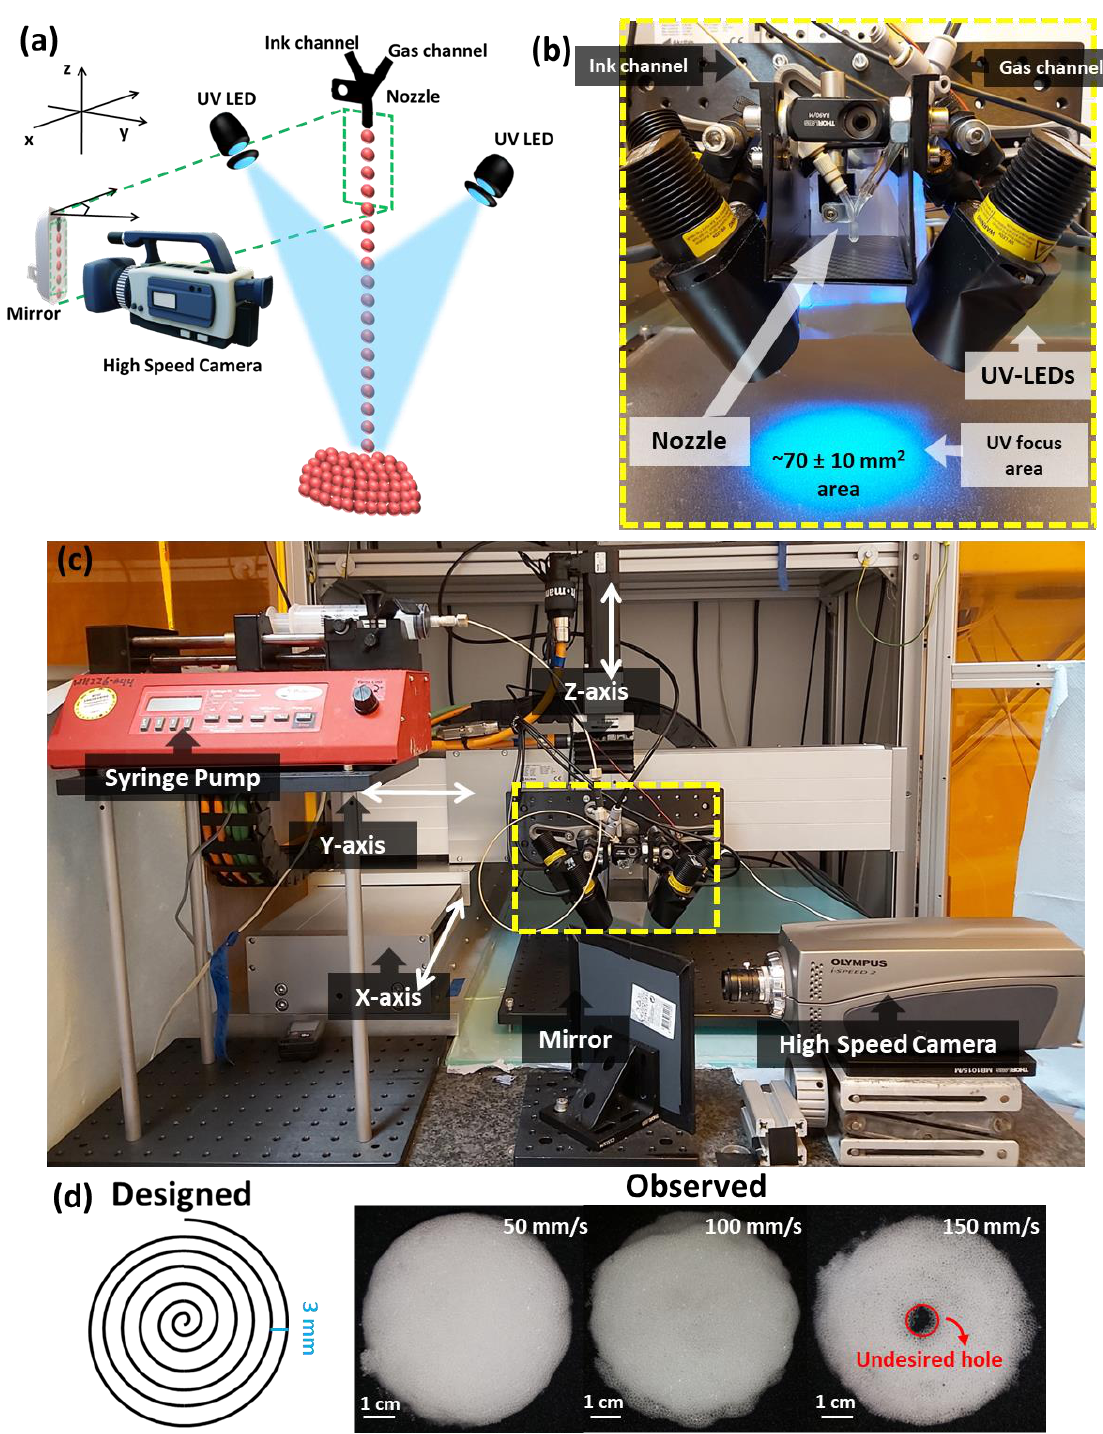
Figure 1. Overview of Direct Bubble Writing (DBW). ( a ) Schematic representation of the DBW setup. Bubbles flow from the nozzle and are captured by a high-speed camera. Down-stream, these bubbles are photopolymerized by 4- UV-LEDs, yielding a foam construct shown in red. ( b ) Photograph of the printhead, with key elements as indicated. ( c ) Overview of the printer. The dashed area is magnified in ( b ). ( d ) The designed pattern (left) was printed at three different velocities of the printhead. For high velocity (150 mm/s), the print showed an unfilled region at the center of the disk. Reducing the printhead velocity mitigated this issue. Samples were printed with a printhead acceleration 𝑎 = 1 m/s 2 , a gas pressure 𝑃 = 7 kPa, and a flow rate of the resin 𝑄 = 15 mL/min.